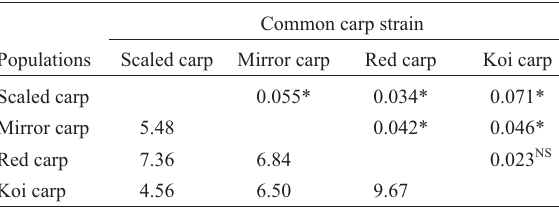
Table 3 - Multilocus F ST (upper diagonal) and N m (below diagonal) values between pairs of four common carp strains across all loci.